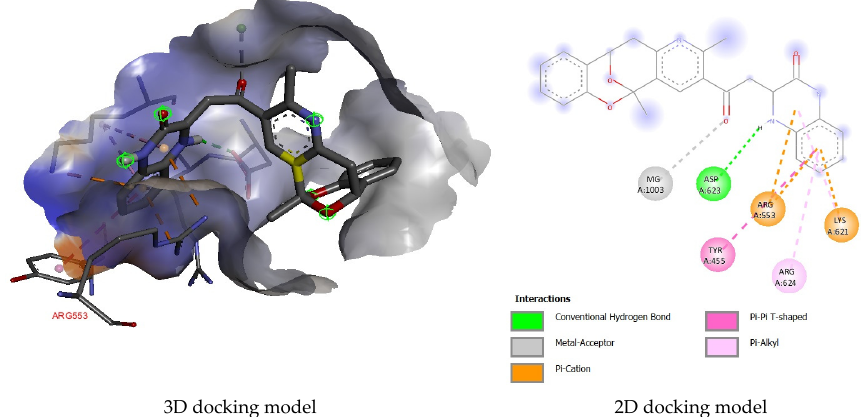
Figure 5. С omplex between 6a and SARS-CoV-2 RNA-dependent RNA polymerase (7AAP). Figure 5. Complex between 6a and SARS-CoV-2 RNA-dependent RNA polymerase